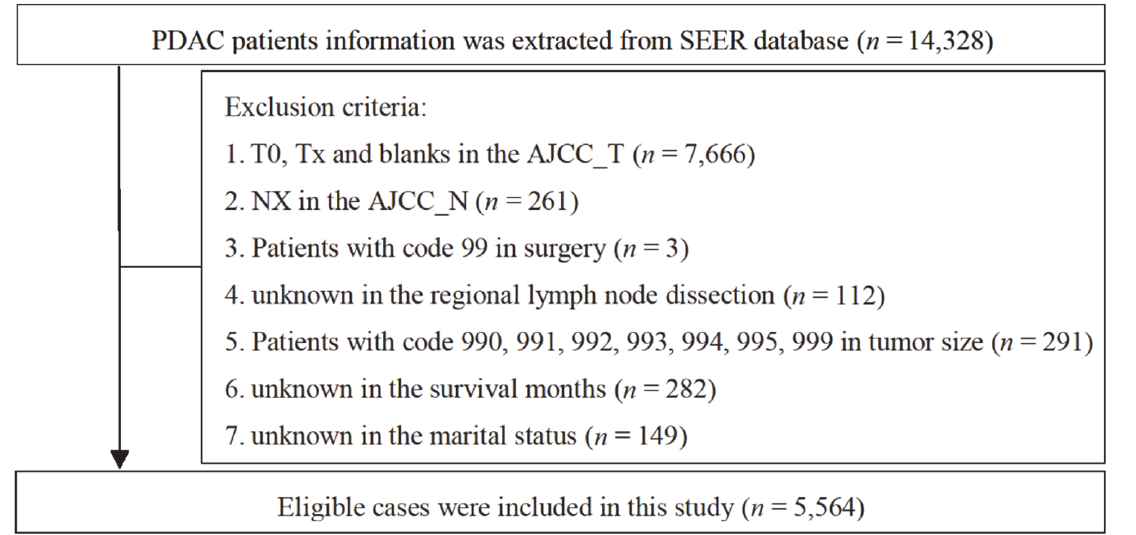
Figure 1. The flow chart of eligible patients’ selection in this study.